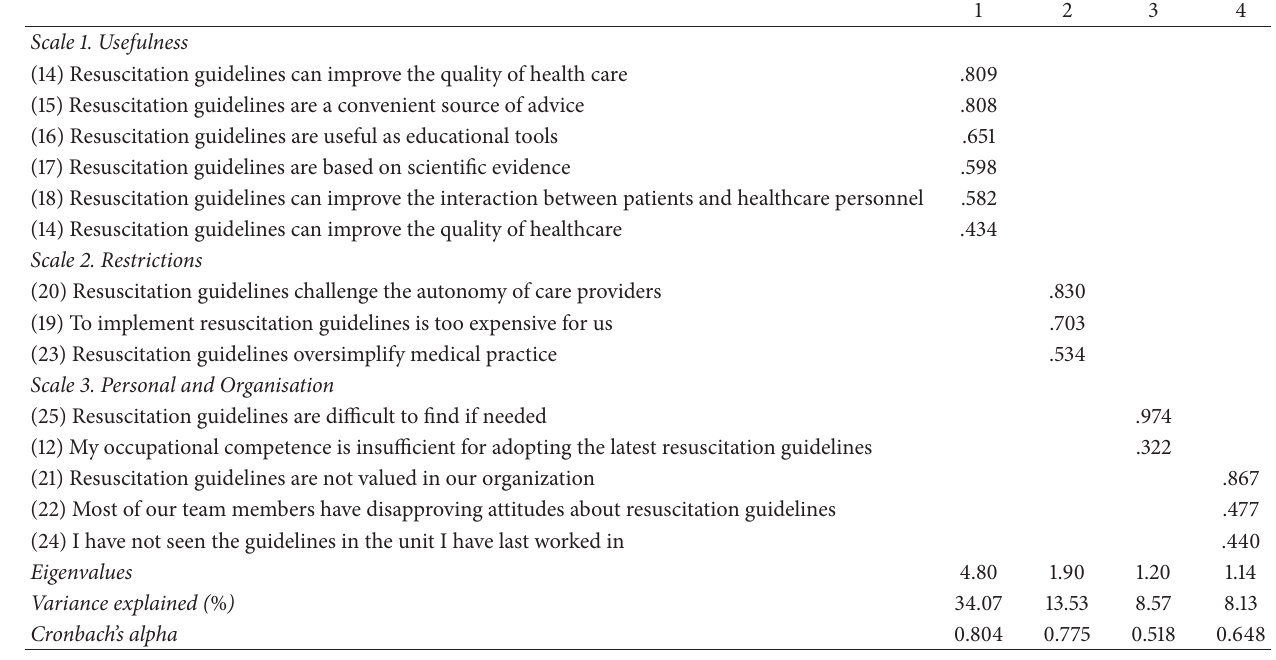
Table 2: Factor loading of the questionnaire distributed to the nurses consisting of 58 items using maximum likelihood and varimax rotation. Eigenvalues, total variance explained by factors, and Cronbach’s alphas for scales are presented in the